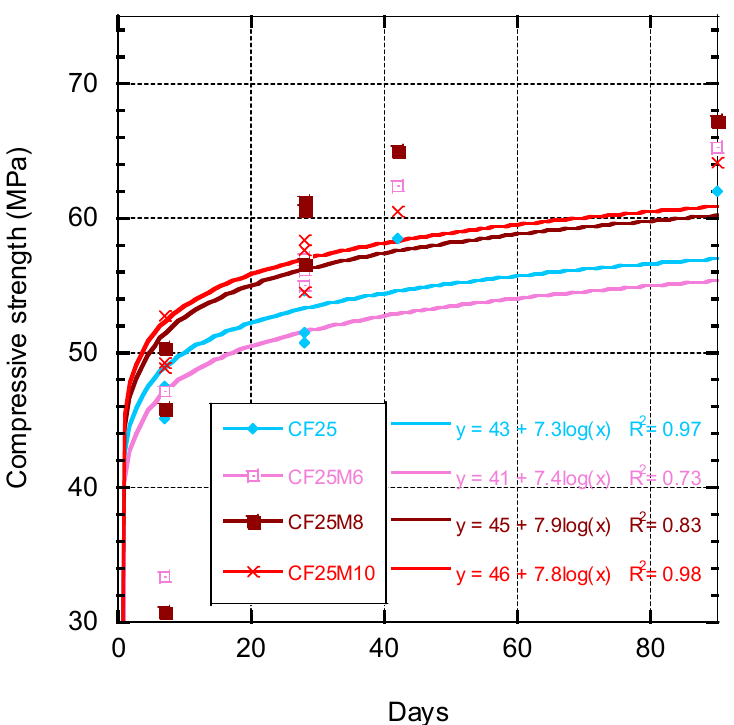
Figure 11. Compressive strength of concrete with different percentages of micro - silica. Figure 12. Compressive strength of concrete with different percentages of micro-silica.